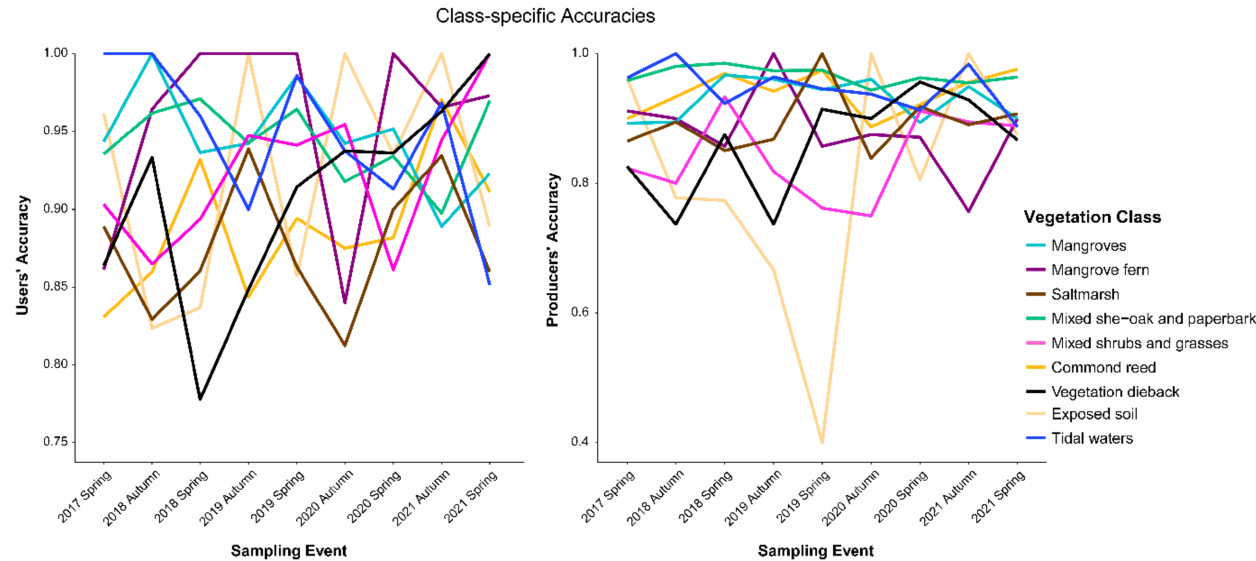
Figure 4. Accuracies of users’ and producers’ for the nine land cover classes on each of the nine maps produced between spring 2017 and